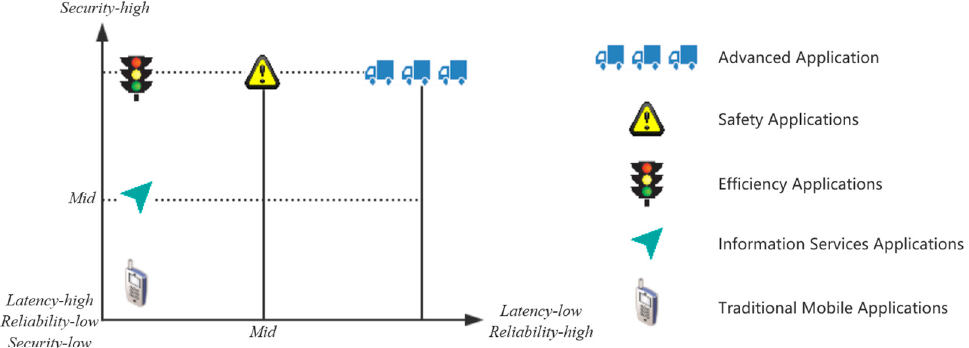
Figure 2. Vehicular Network Applications.